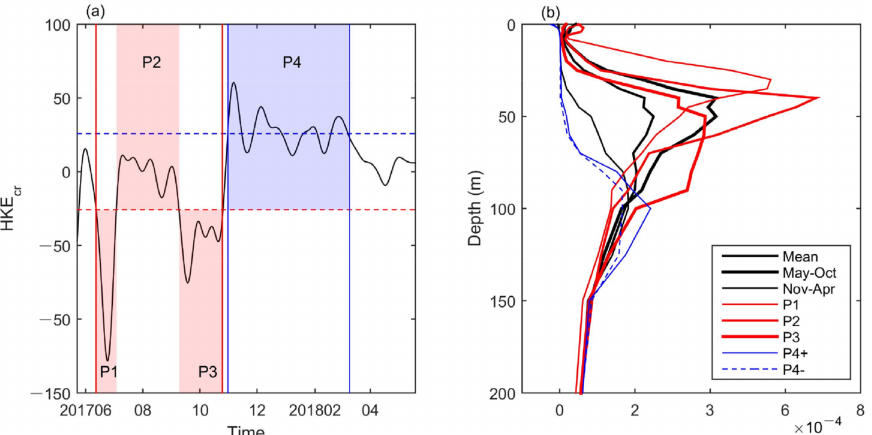
Figure 11. ( a ) Depth-averaged HKE cr (20-day low-pass filtered, unit: J m − 1 ). The red (blue) dashed line represents the -0.75 (0.75) stds of the time series. The red solid lines represent the warm period (from 12 June 2017 to 25 October 2017), and the blue solid lines represent the cold period (from 31 October 2017 to 10 March 2018). P1, P2, P3 and P4 represent the periods from 12 June 2017 to 4 July 2017, from 5 July 2017 to 9 September 2017, from 10 September 2017 to 25 October 2017 and from 31 October 2017 to 10 March 2018, respectively. ( b ) Profiles of the mean Brunt-Väisälä frequency squared (unit: s − 2 ) at the mooring location derived from HYCOM analysis data. ‘Mean’ represents the mean value during the whole observation period; ‘May-October’ represents the mean value from May 2017 to October 2017; ‘November-April’ represents the mean value from November 2017 to April 2018; ‘P1 (cid:48) , ‘P2 (cid:48) and ‘P3 (cid:48) represent the mean value during the P1, P2 and P3 periods, respectively; ‘P4+’ (‘P4 − ’) represents the mean value when the HKE cr was larger (lower) than 0.75 stds during the P4